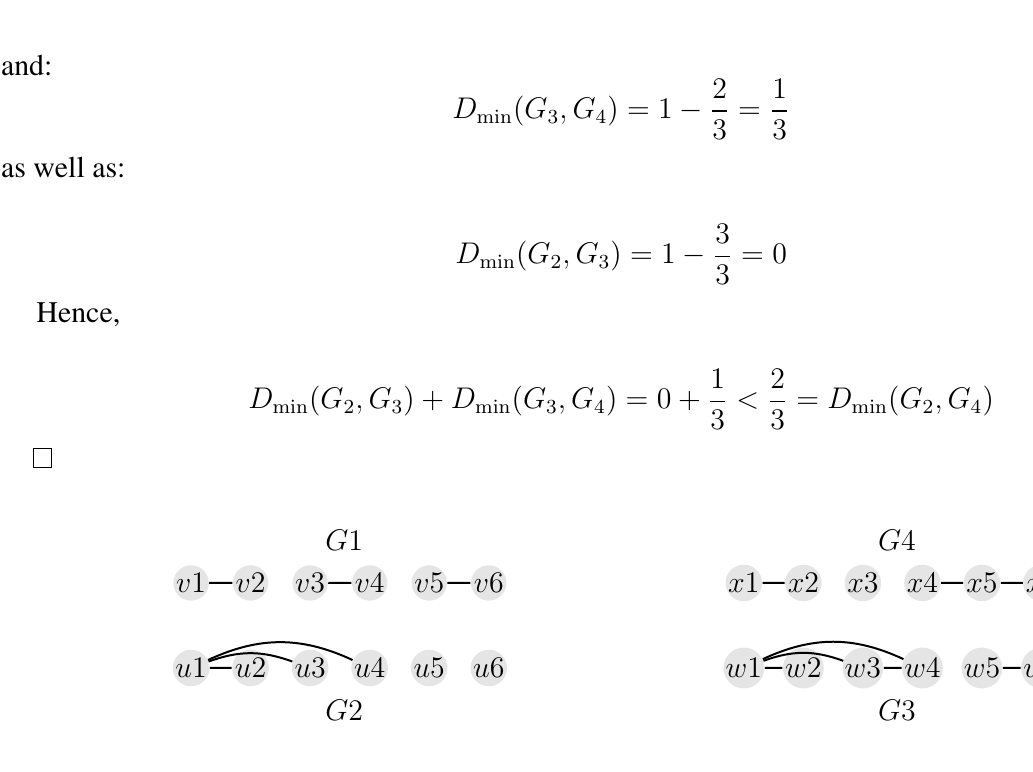
Figure 2. Four contact map